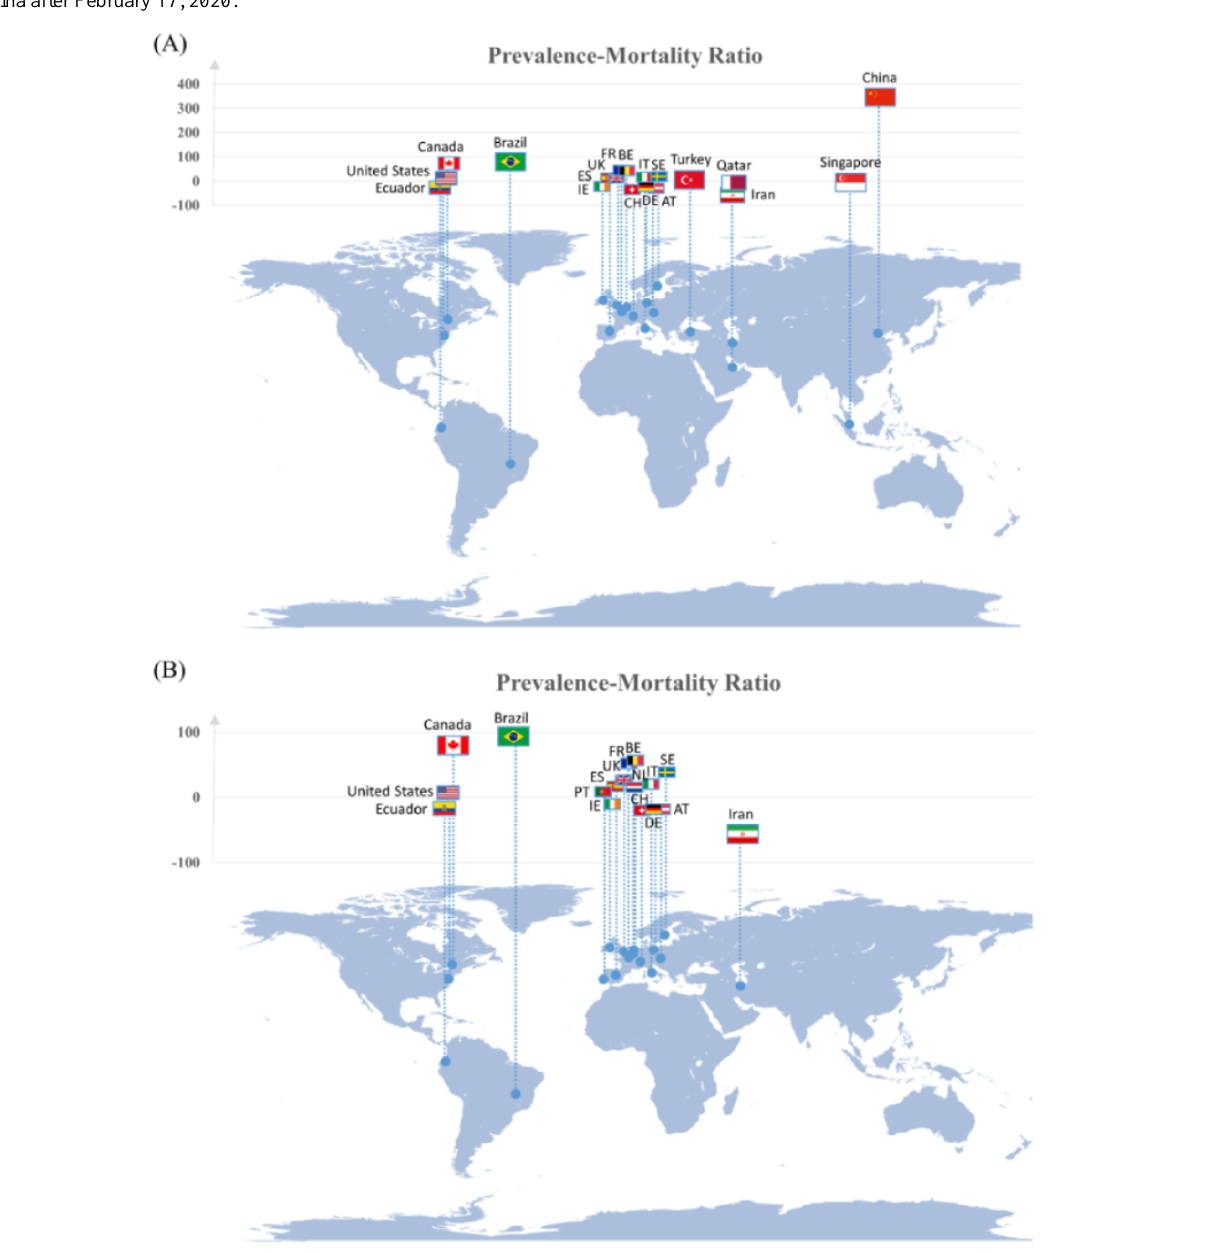
Figure 3. Countries with significant country-specific mortality-prevalence ratios based on (A) all data and (B) all data excluding those collected from China after February 17,